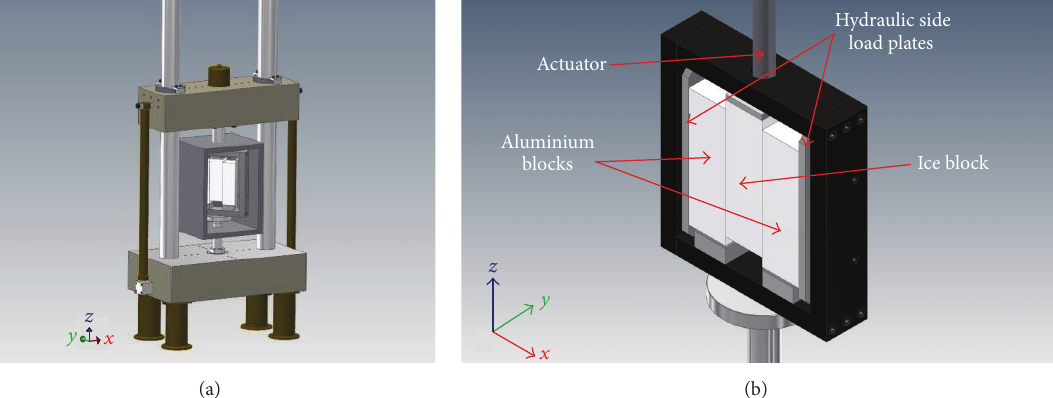
Figure 2: (a) shows the loading apparatus, comprising a 20 T uniaxial compression rig, an environmental chamber, and a shear loading frame; (b) shows a close-up of the shear load frame.